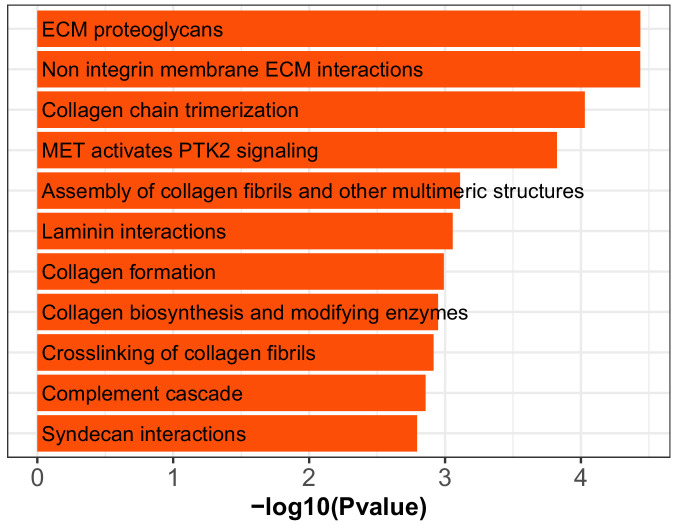
Enriched REACTOME gene sets for lung myofibroblast cells in mice exposed to IH vs controls.The GSEA was run on expressed genes in myofibroblast ranked by the fold change between IH and control samples. The significantly enriched gene sets were selected by padj<0.15 and absolute NES value above 1.7.